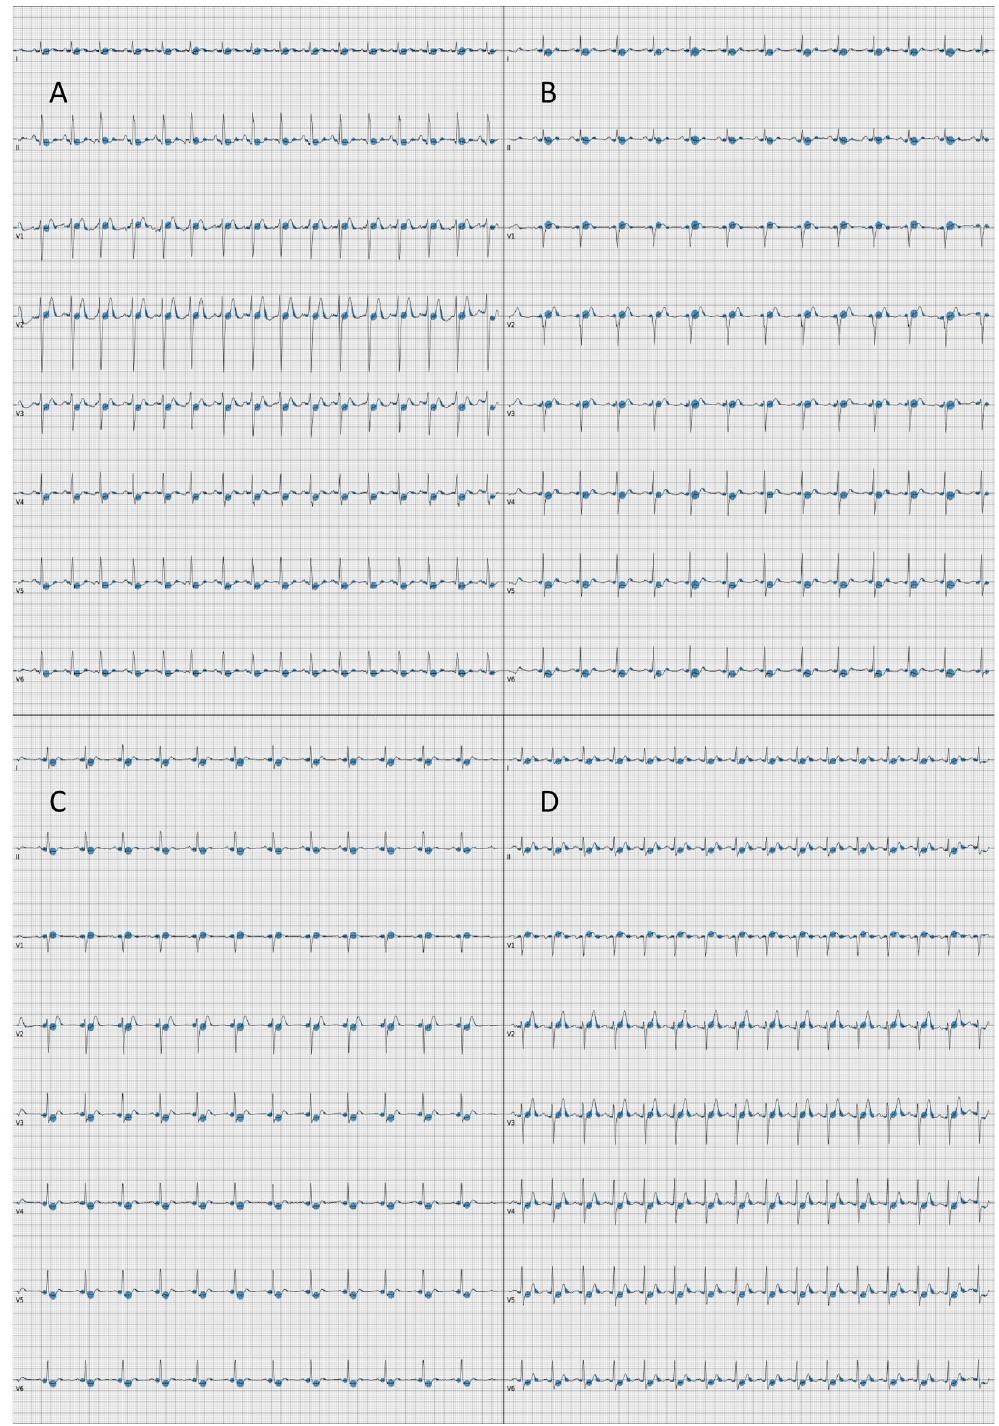
Figure 3. Four representative NSTEMIs correctly classified with high probability. Four Grad-CAM plots of NSTEMIs correctly classified with high probability, highlighting the parts in the ECG that the model focuses on for its prediction. Gradients corresponding to the activations in the first convolutional layer of the neural network are averaged to get the proportional importance of each channel, which is then used to compute a proportional mean of the activations. Positive values obtained were plotted as blue disks overlaid on top of the ECG, with size proportional to its